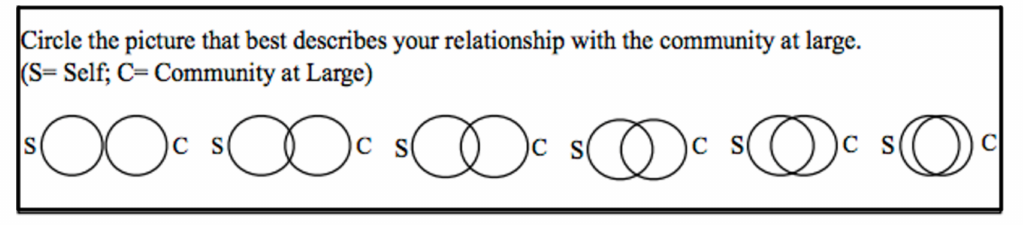
Figure 1. Inclusion of Community in the Self